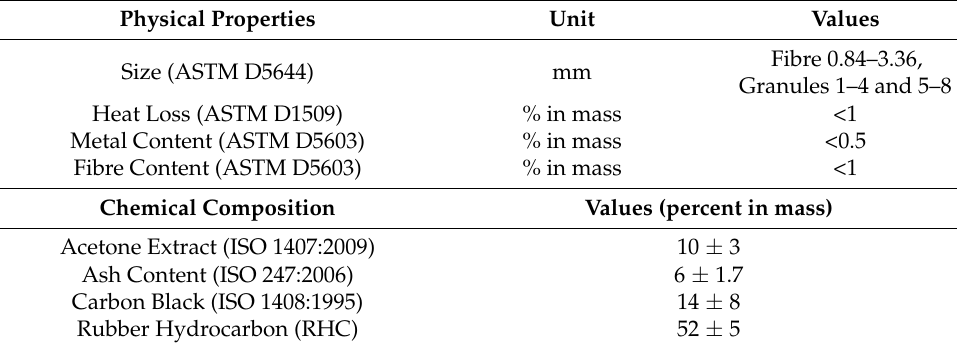
Table 2. Physical and Chemical properties of rubber